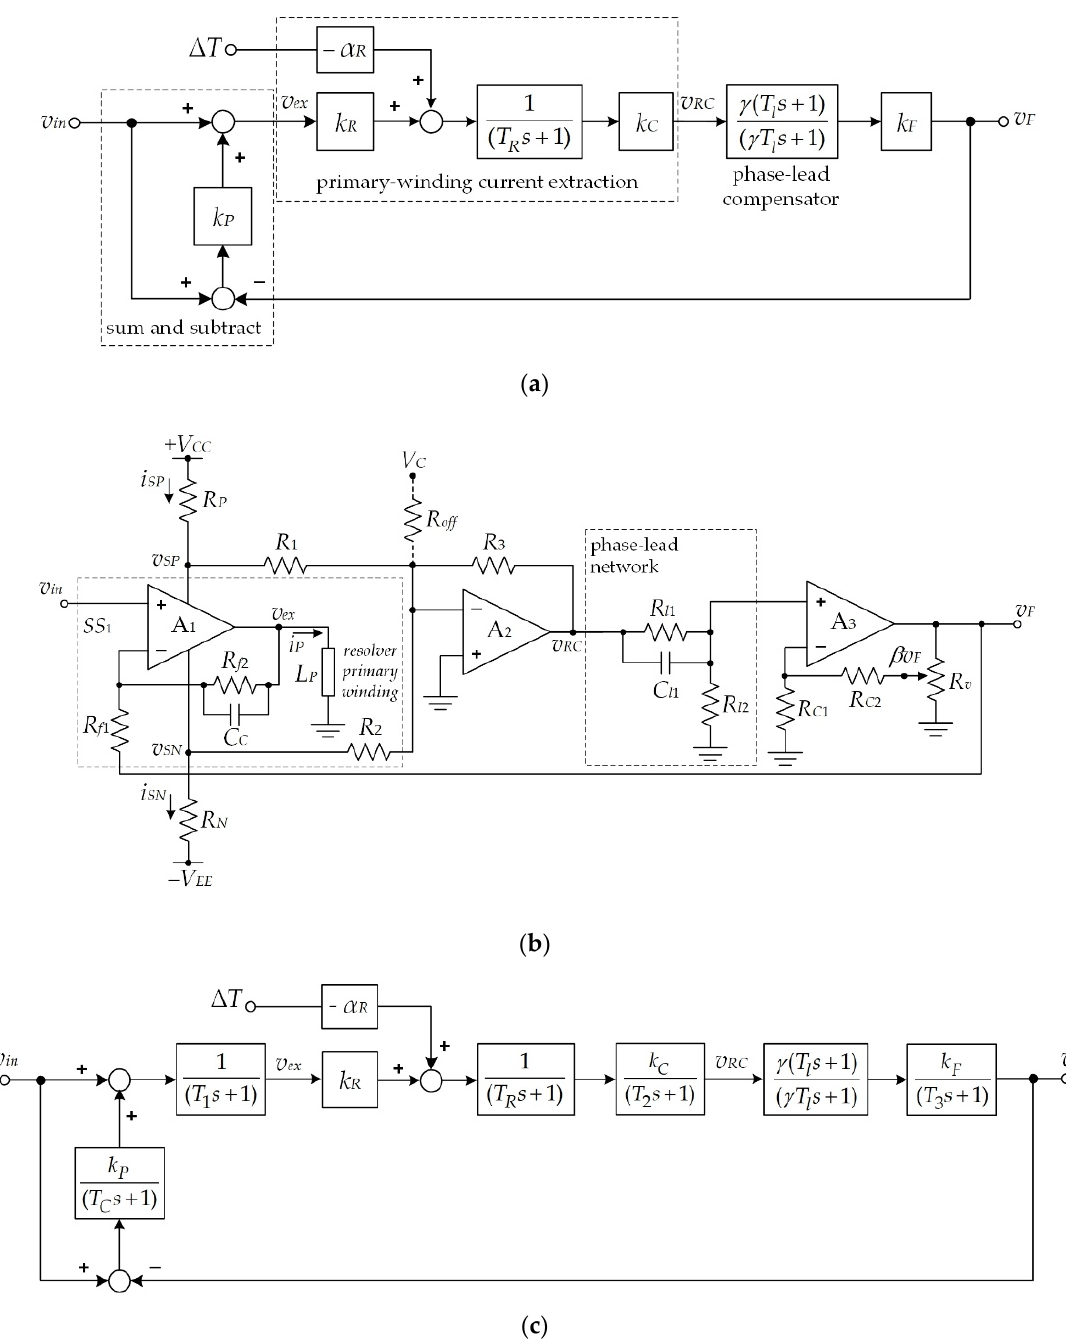
Figure 4. ( a ) Principle of the temperature-compensation technique; ( b ) the proposed circuit; ( c ) block diagram of the proposed circuit.